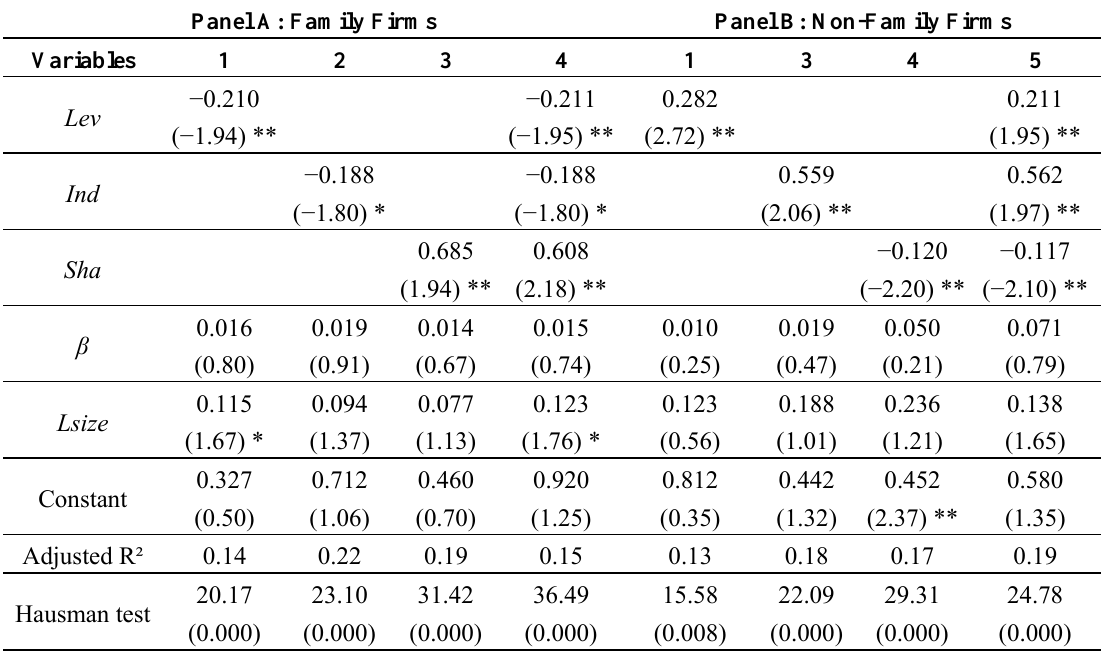
Table 4. Results of estimations based on family and non-family sample (family holds more than 40 percent